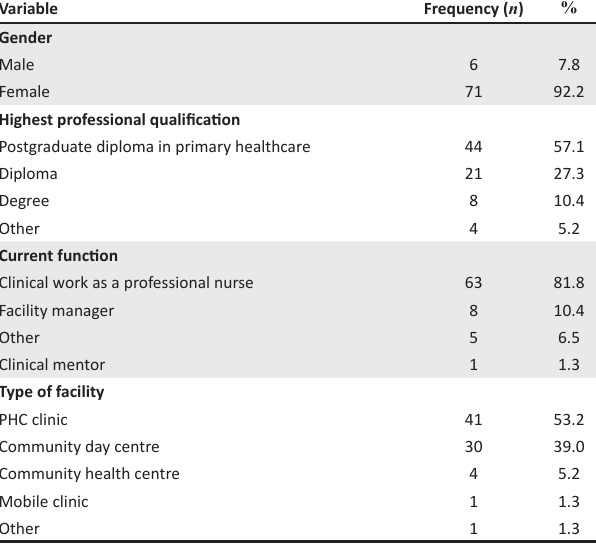
TABLE 1: Biographical data of the